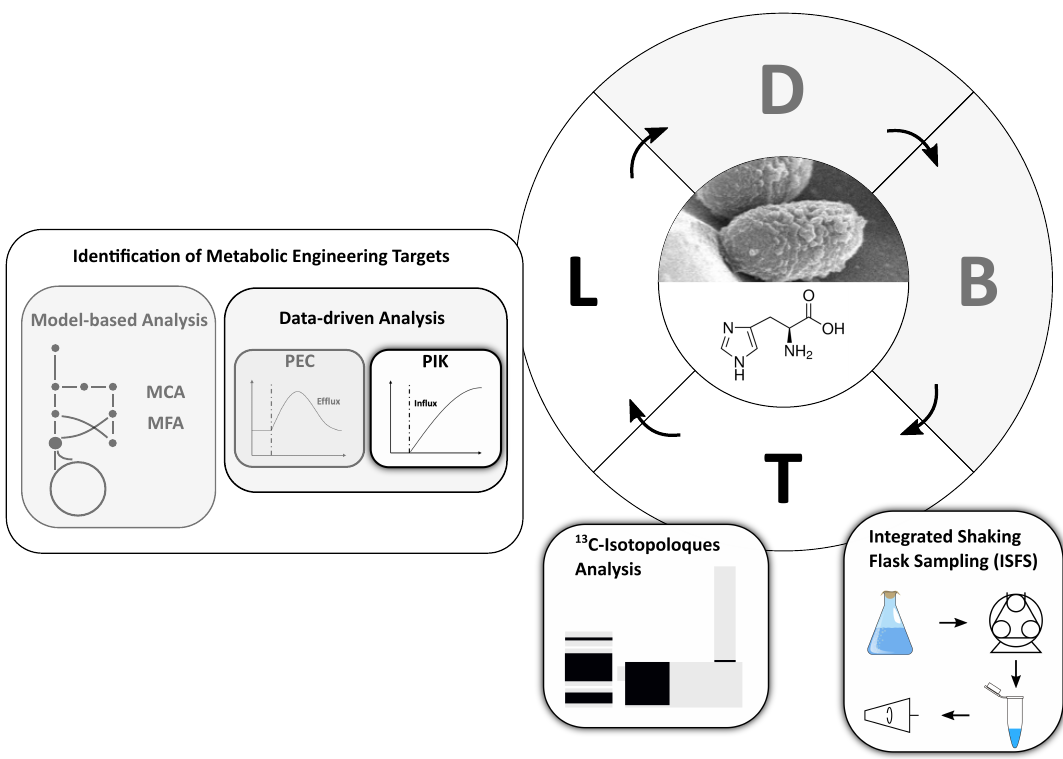
Figure 2. Schematic overview of the design-build-test-learn (DBTL) cycle for the l -histidine production with C. glutamicum . Highlighted modules were developed and applied in this work. Grey modules were not performed, but are depicted to classify the novelty of the pool influx kinetics (PIK)